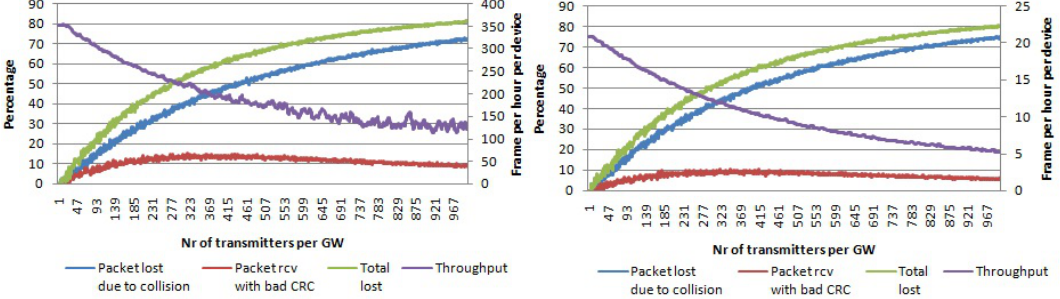
Figure 8. Percentage of packets lost due to collisions and the percentage of packets received with the wrong payload CRC per number of transmitters per gateway. Average throughput per device. Multiple channels, single SF and payload size 20 bytes. ( left ) Using SF 7; ( right ) using SF